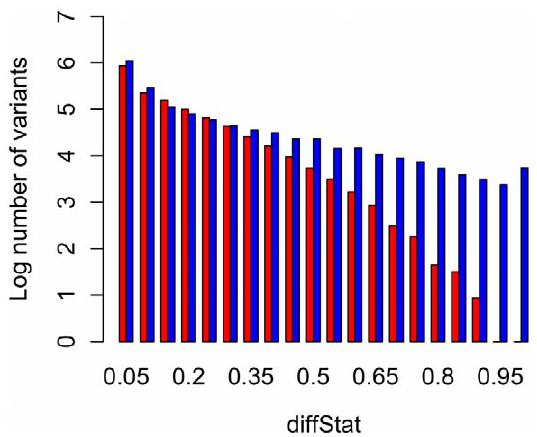
Figure 3. Frequency histogram of differentiation between treatments, on a log scale. The distribution of the diffStat is shown, when the two large- and two small-selected populations are considered together; this is compared to the expected distribution obtained via simulation. Blue=observed, red=simulated drift. Note the log scale.